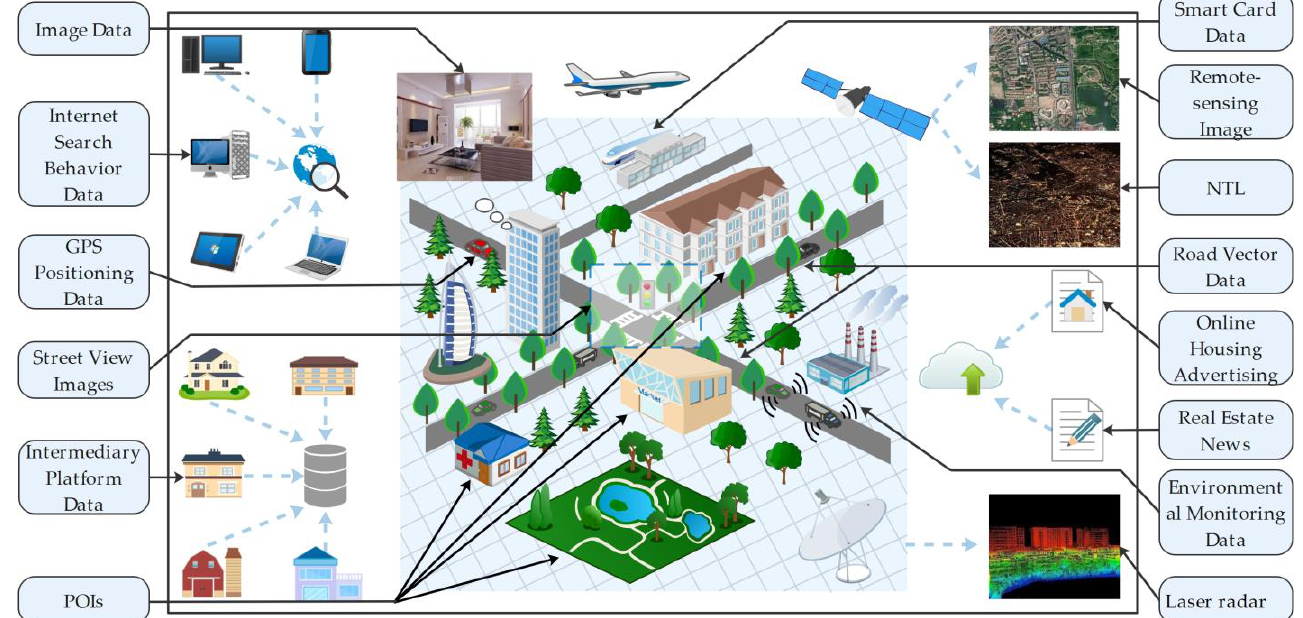
Figure 3. Schematic diagram of big data applied to real estate appraisal (Adapted from Kong et al. [87]).